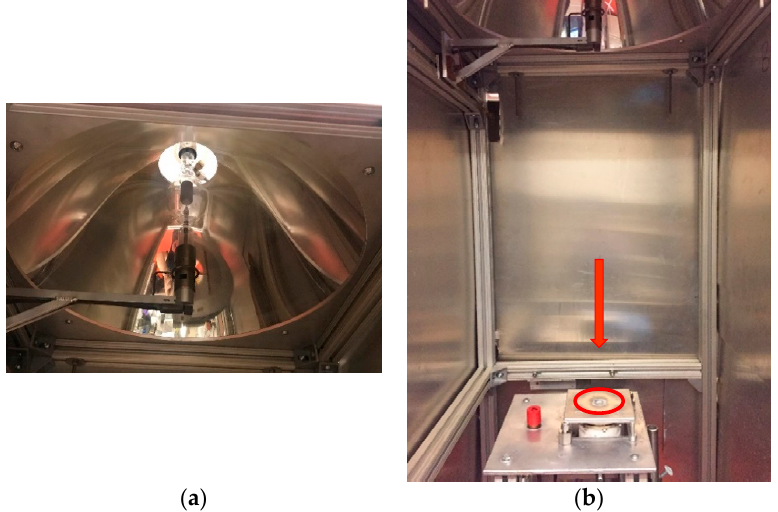
Figure 3. ( a ) Solar simulator lamp and mirror reflector; ( b ) target underneath reflector.